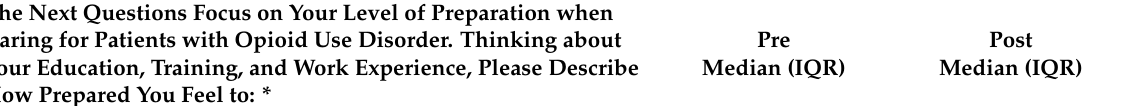
Table 1. Pre-and Post-training Preparedness and Barriers to using Medication for OUD ( n =